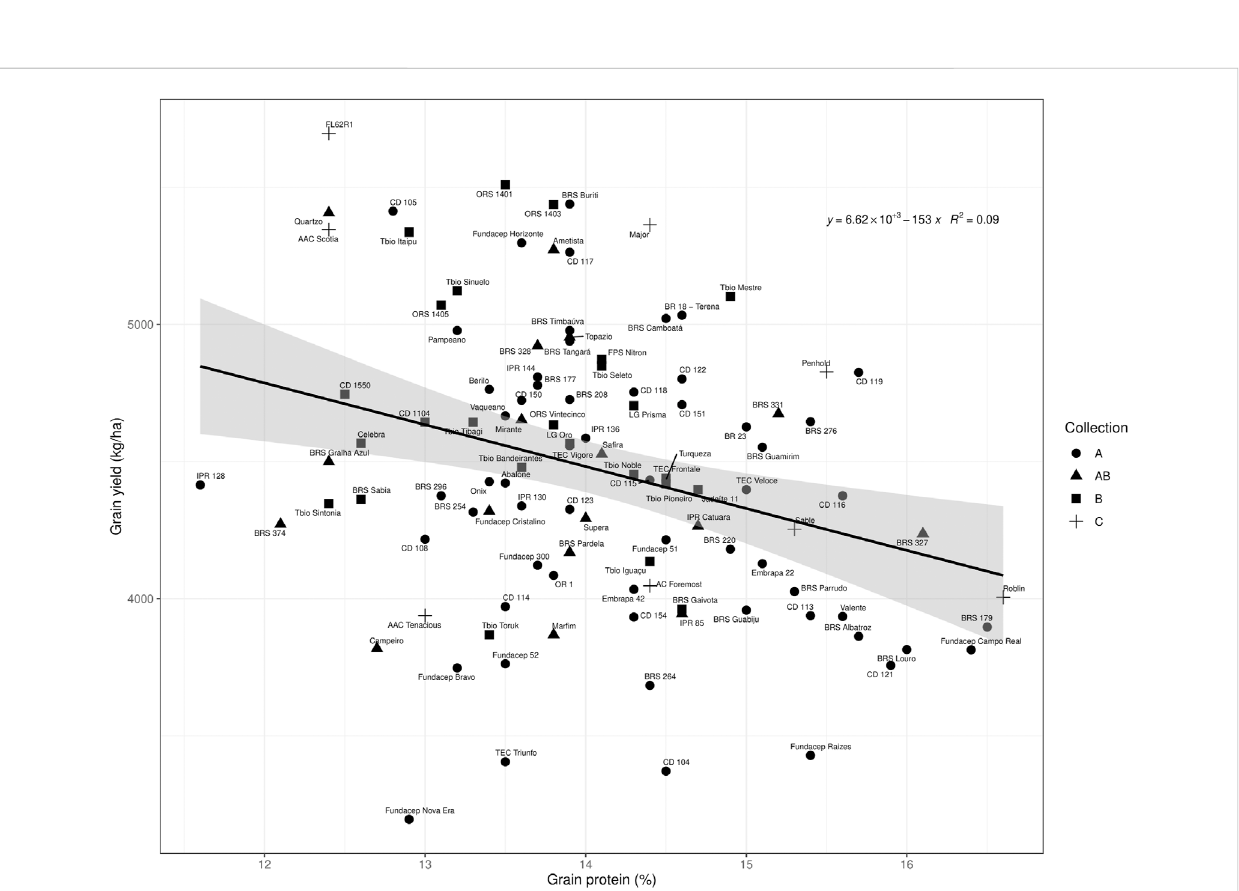
FIGURE 1 Grain yield by grain protein plot of the Brazilian collections and Canadian checks evaluated at Saint-Mathieu-de-Beloeil in 2018. The material was divided in collections: “ A ”— cultivars registered in Brazil from 1986 to 2012, but not recommended for cultivation in Brazil after 2015; “ B ” : cultivars registered from 1999 to 2016 and still in recommendation to be cultivated in 2015; “ AB ”— cultivars present in both collections, still in recommendation after 2015. “ C ” represents Canadian checks. The linear regression line is in black and the con fi dence interval (0.95) is displayed in